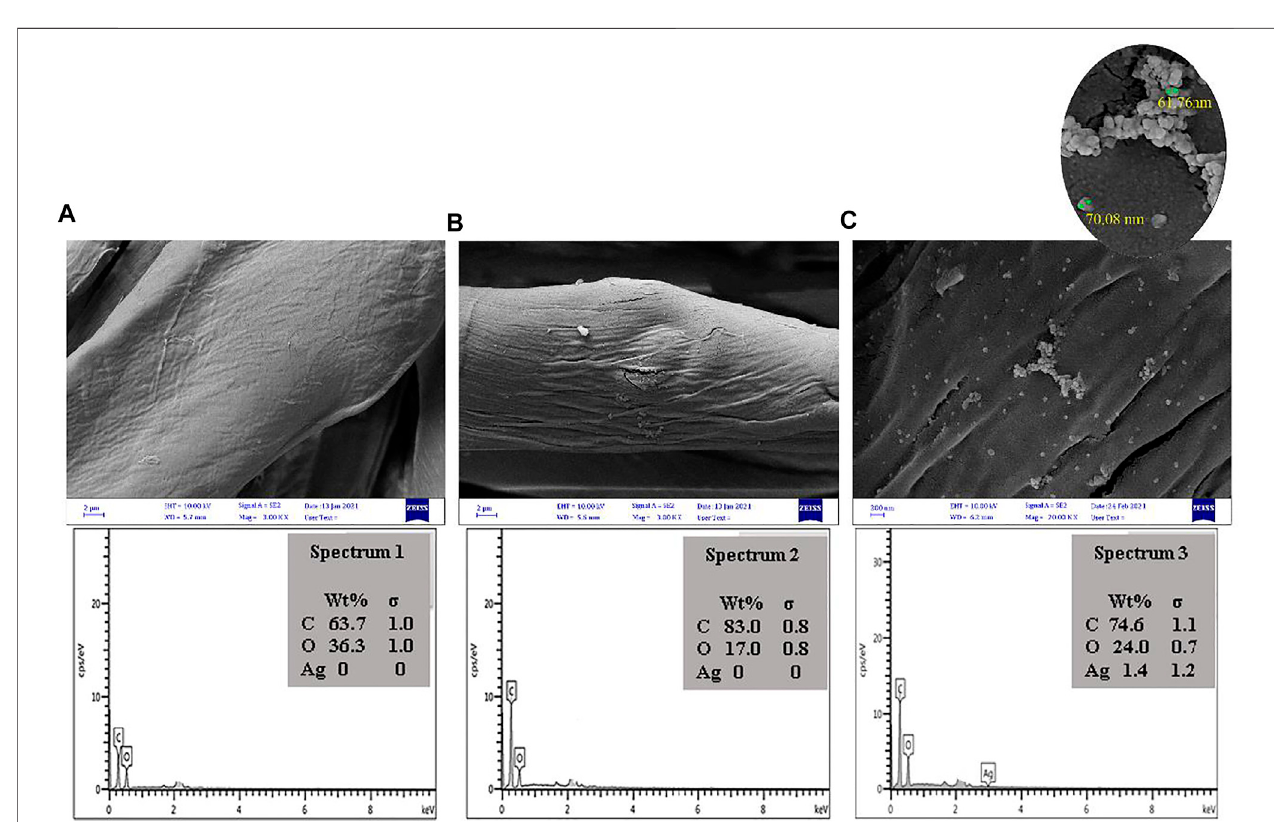
Frontiers in Bioengineering and Biotechnology |